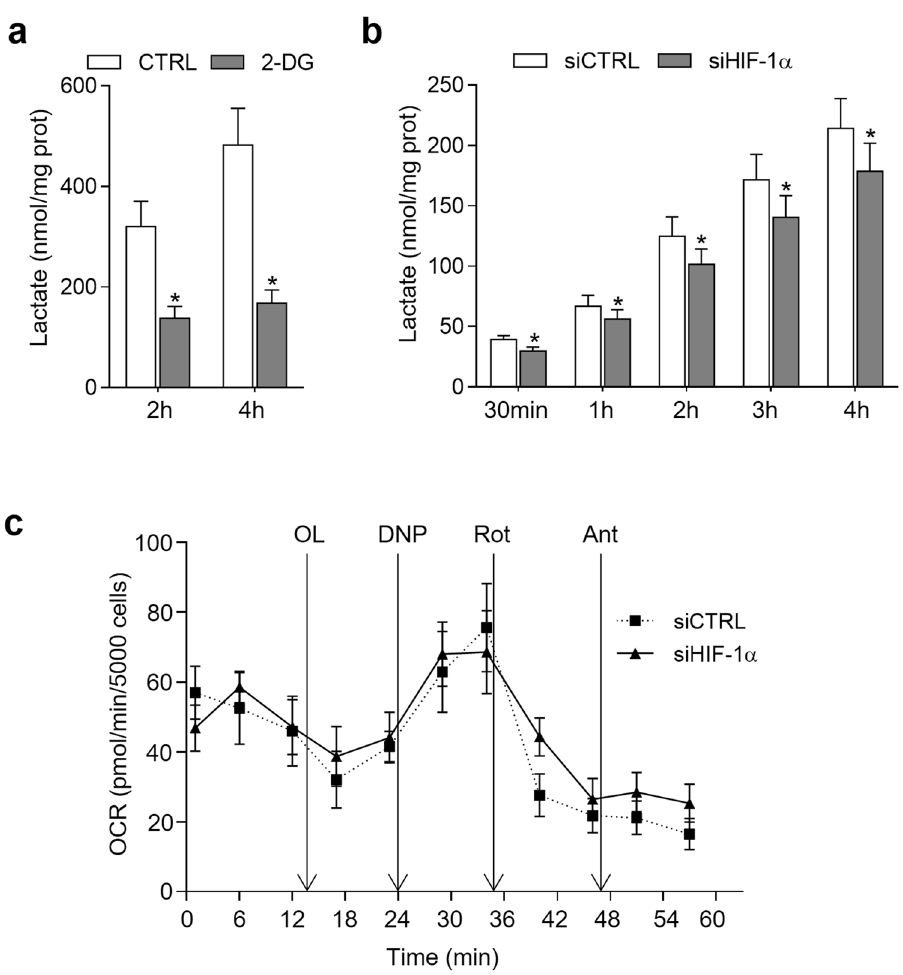
Figure 2. Analysis of energy metabolism in SF. ( a ) Lactate production by SF (n = 6) at 2 h and 4 h after 2-DG treatment (40 mM) ( * p = 0.03 in all comparisons, Wilcoxon test) (Mean ± SEM are indicated). ( b ) Lactate production in HIF-1 α silenced and non-silenced (CTRL) SF cultures at 30 minutes, 1 h, 2 h, 3 h and 4 h after media replenishing. Data represent mean ± SEM of 3 independent experiments ( * p = 0.03 in all comparisons, Wilcoxon test). ( c ) Real-time analysis of OCR in HIF-1 α or non-silencing (CTRL) siRNA lentiviral transduced SF after the sequential addition of OL, 2,4-dinitrophenol (DNP), rotenone (Rot) and antimycin (Ant) to the cells. Results are representative of 5 replicates from 2 independent experiments (Mean ±